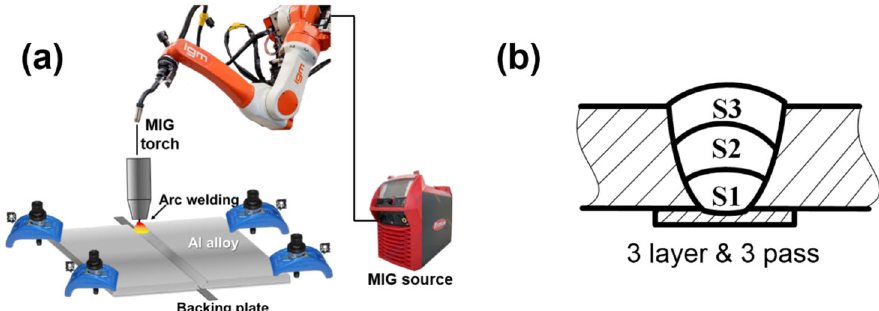
Figure 1. The schematic of gas metal arc welding (GMAW) of aluminum alloy. ( a )welding diagram; ( b ) three ‐ layer and three ‐ pass welding layer arrangement. Table 3. The process parameters employed in this study.